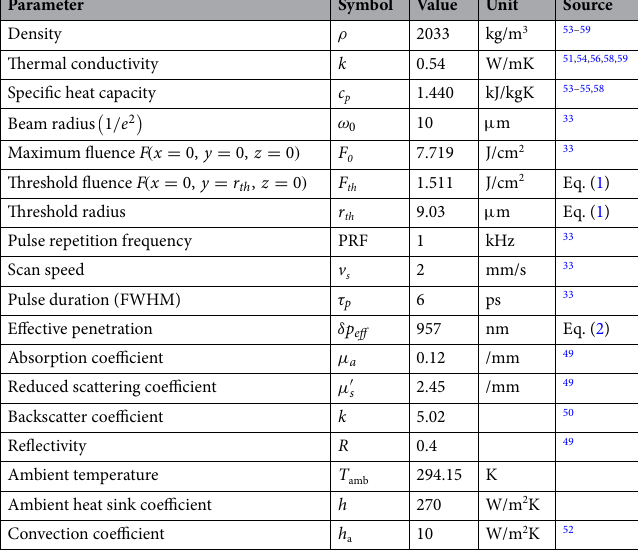
(Table 1). Groetsch et al. 33 used MTLT as a model system for bone in their studies to facilitate the extraction of micropillars from individual mineralised collagen fibres for their micro- and nanomechanical testing. At the microscale, the MTLT exhibits the same hierarchical setup as bone 37–39 . For this reason, we used published val- ues for cortical bone. The studies from which these parameters were obtained were observed at the macroscopic length scale. We used these as no data was available for the mineralised collagen fibre level. As cortical bone exhibits a low macroporosity (5–15%) 17 , we assume these properties scale down to the micrometre length scale. Further to this, Davidson and James 51 report that heat transfer in cortical bone can be regarded as isotropic. Therefore, the general heat equation that we modelled was: